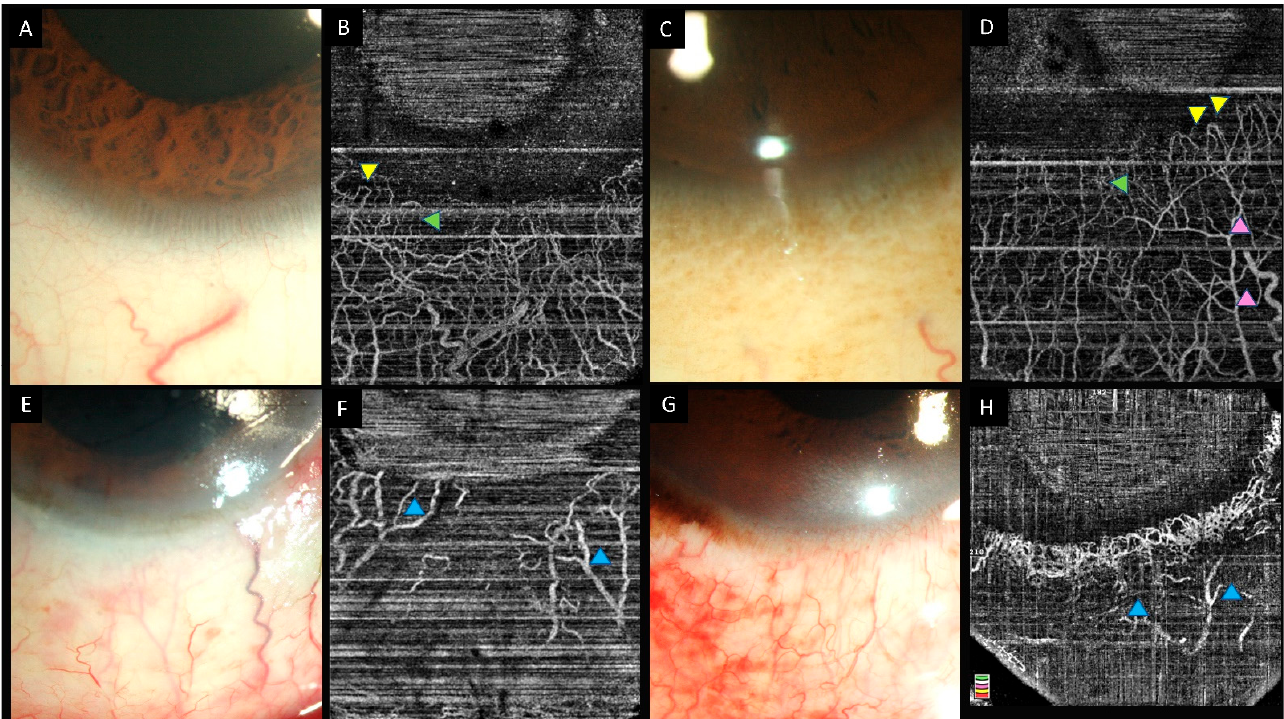
Figure 3. ( A – D ) Collage of images of the slit lamp and anterior segment optical coherence tomography angiography images of eyes with normal limbal and perilimbal vasculature. Hairpin loop vessels are noted at the corneal end of the limbus (yellow arrowheads). A combination of both Y-shaped (pink arrowheads) and radial vessels (green arrowheads) are noted in the angiography images. ( E – H ) Slit lamp and OCTA images in eyes with chemical injury illustrating ischemic zones in both angiographies with distortion of the limbal vasculature (blue arrowheads).